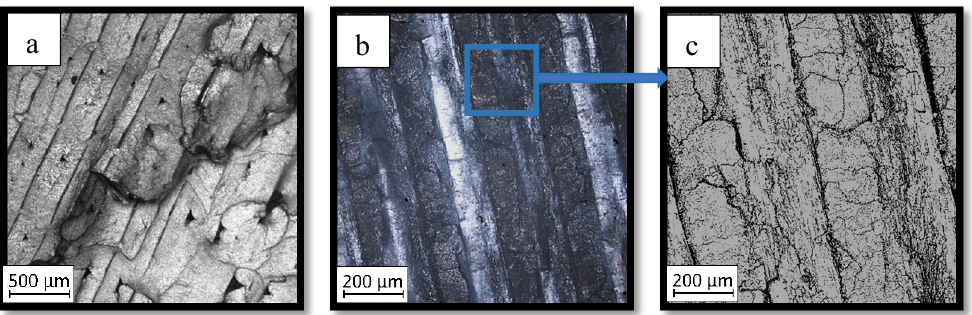
Figure 12. Fracture images for ABS ( a ) and PLA Tough™ ( b , c ).